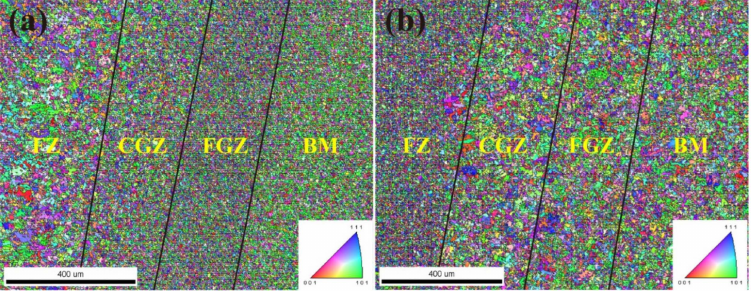
Figure 20. Distribution of grain orientation: ( a ) before quenching; ( b ) after quenching.